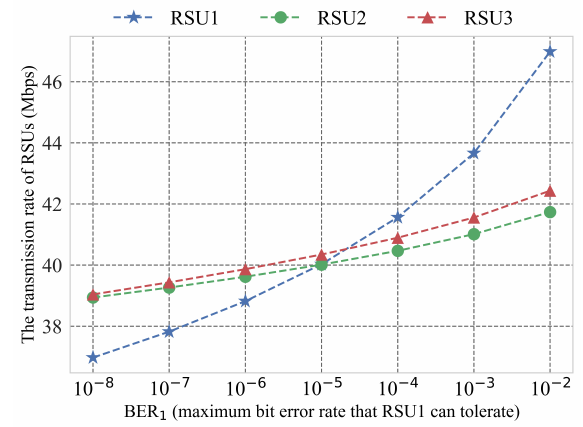
Figure 3. The transmission rate of RSUs vary with the BER 1